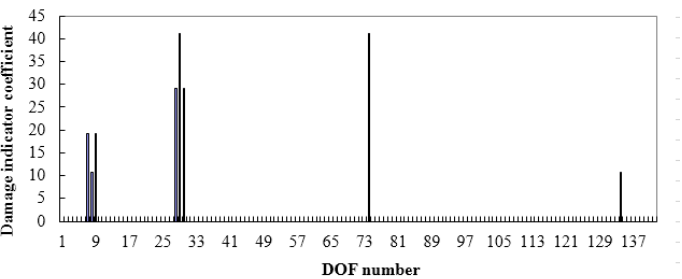
Figure 5. Damage indicator vector when cables 10 and 30 were damaged.